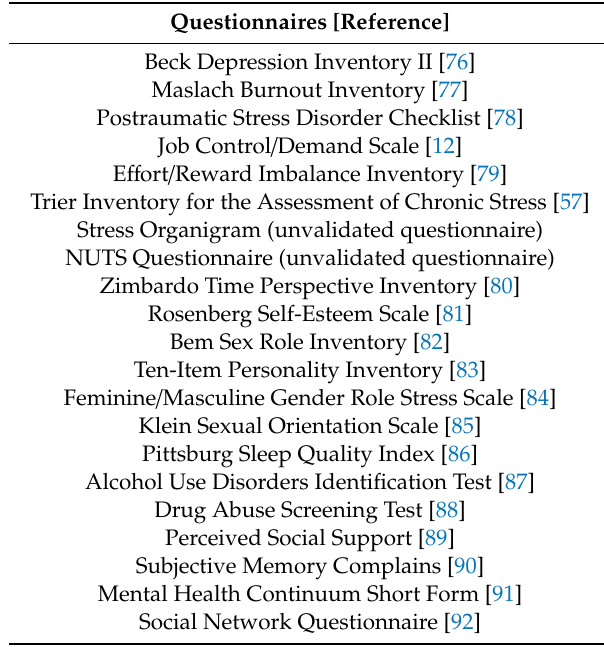
Table A2. Full list of questionnaires used in the original